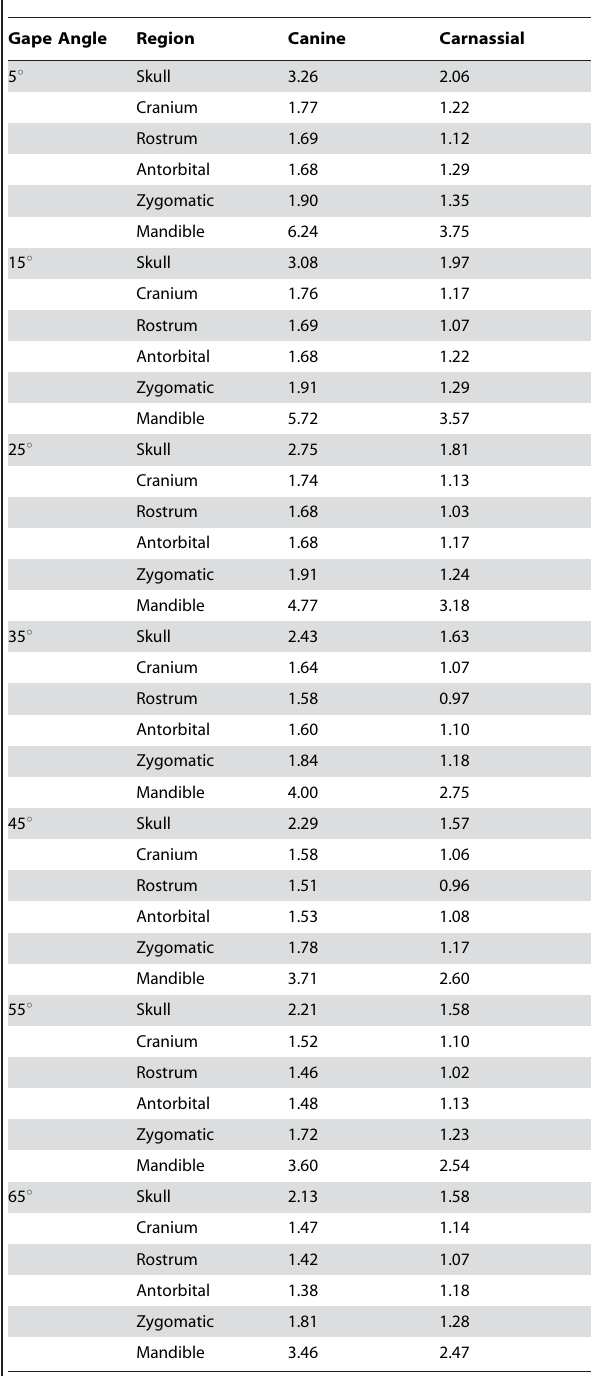
Table 2. Mean brick stress (VM) of select skull regions during static bite tests at various angles and jaw regions for solved FE models for C. l. dingo.